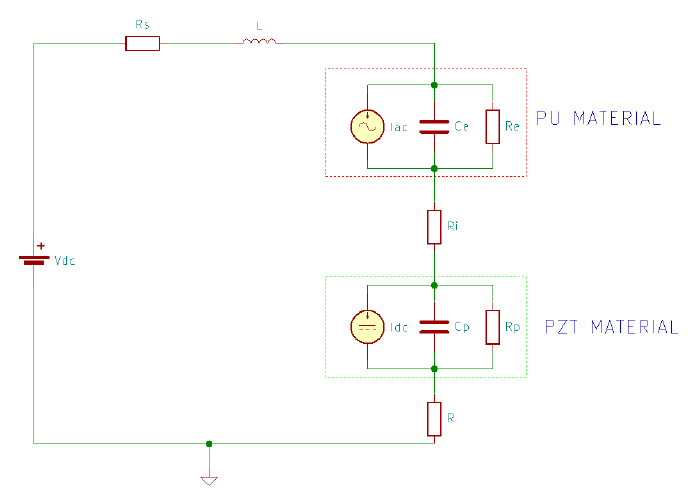
Figure 12. The equivalent circuit model [1].